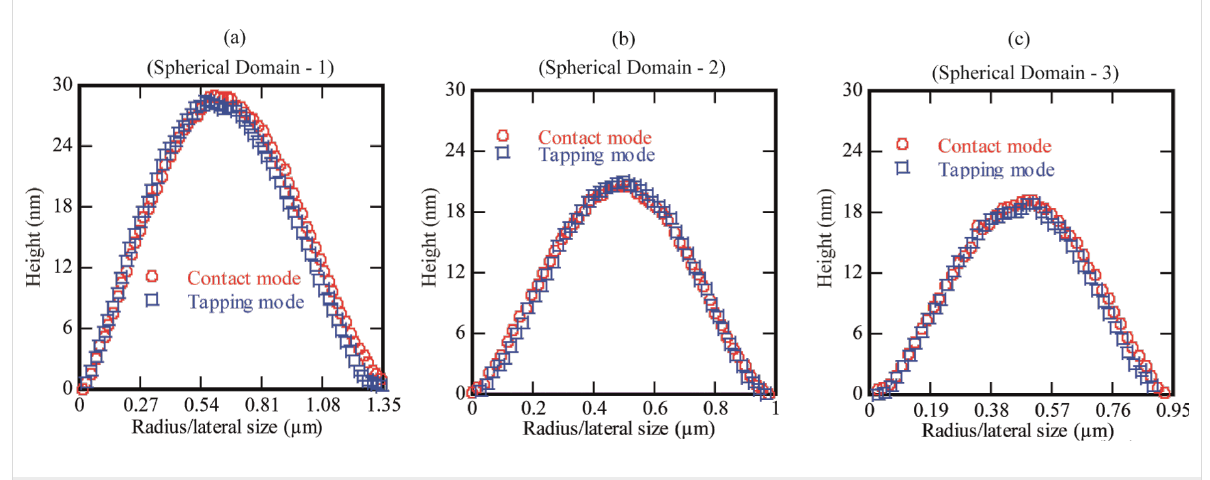
Figure 6: Section analysis of spherical domains imaged in contact mode and tapping mode (shown in Figure 5). (a) Section of spherical domain (1). (b) Section of spherical domain (2). (c) Section of spherical domain (3). The circles show the section of the spherical domain imaged in contact mode while the squares show the section of the spherical domains imaged in tapping mode.